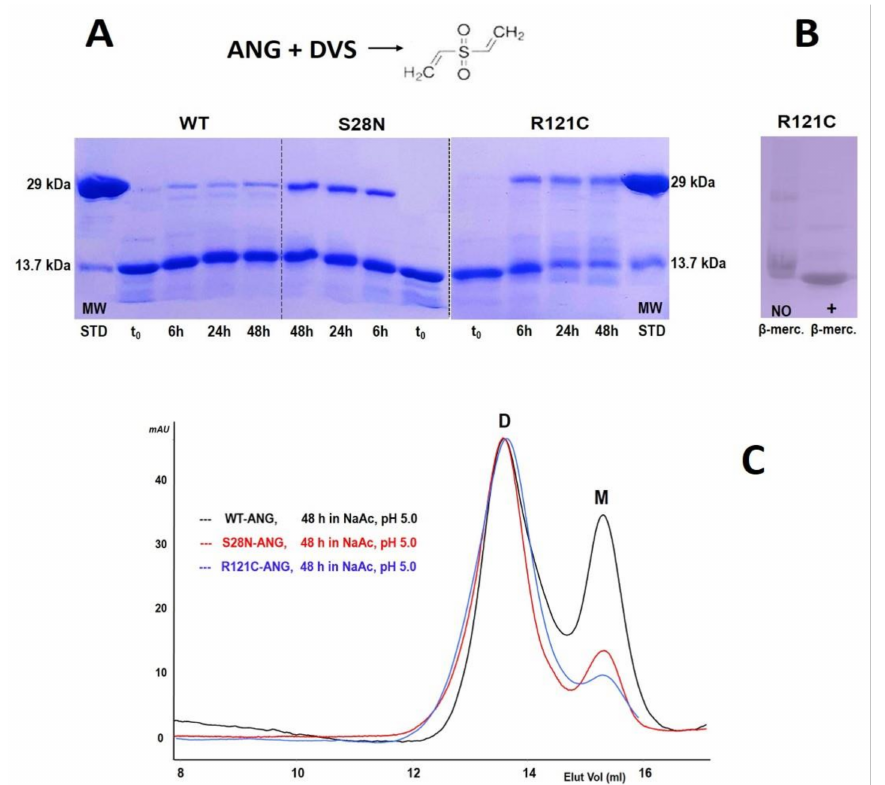
Figure 4. Analysis of ANG-D. ( A ): 15% acrylamide SDS-PAGE of the cross-linking reaction of ANG-D of WT, S28N, and R121C-ANG variants performed with divinyl sulfone (DVS), whose structure is reported in the panel; ( B ): 15% acrylamide SDS-PAGE of R121C-ANG under reducing or non- reducing conditions. Gels were run in both panels at 200 V for 80 min; ( C ): SEC analysis of ANG-D upon its incubation at RT for 48 h in 0.1 M sodium acetate/HAc buffer, pH 5.0. M: monomer, D: dimer. All chromatograms have been registered with a 0.20–0.25 mL/min flow rate in the same Superdex 75 HR 10/300 Increase column equilibrated with 0.20 M NaPi, pH